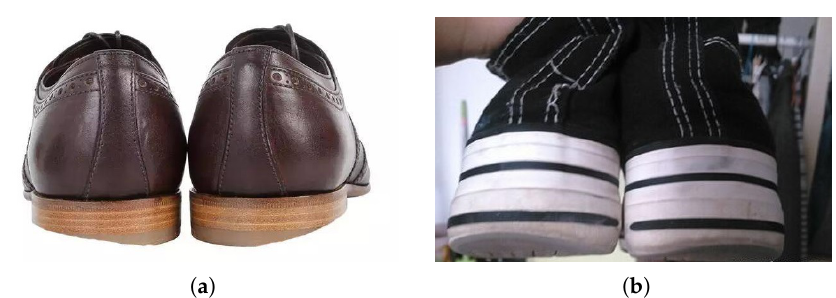
Figure 1. Abnormal gaits reflected in the soles of shoes. ( a ) Strephenopodia is present on both sides; ( b ) apparent asymmetry on both sides.